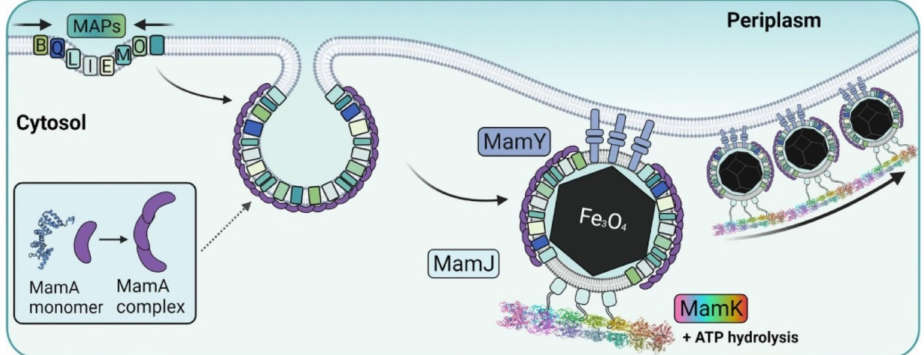
Figure 16. Suggested model of protein sorting, membrane invagination, and magnetosome assembly into an organized chain. Proteins solved structures are in ribbon representation. Reprinted from [137], license CC BY-NC-ND